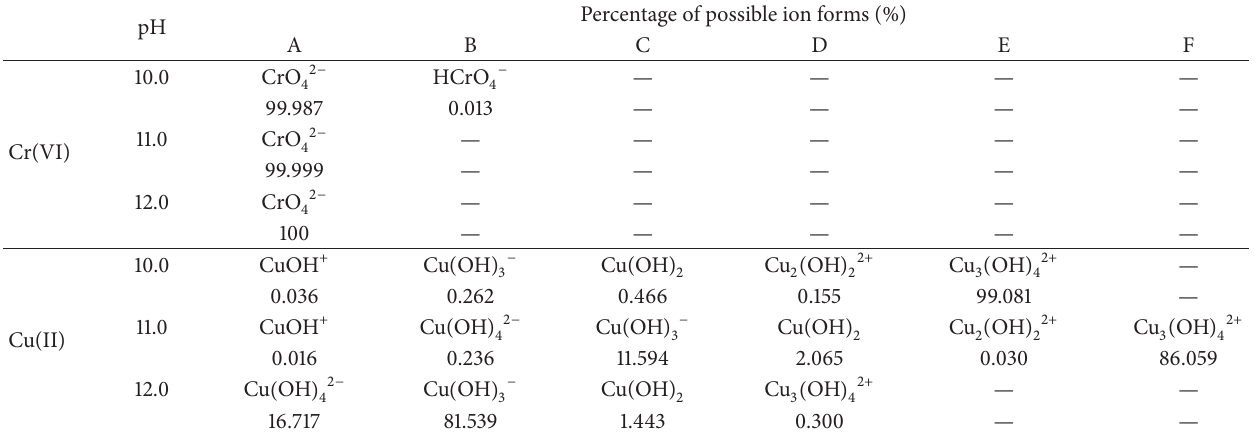
Table 5: The percentage of possible ion forms of Cu(II) and